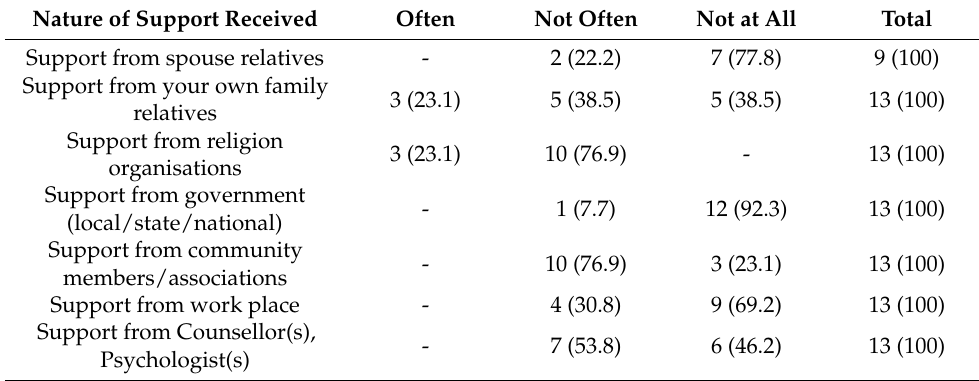
Table 3. Frequency of support